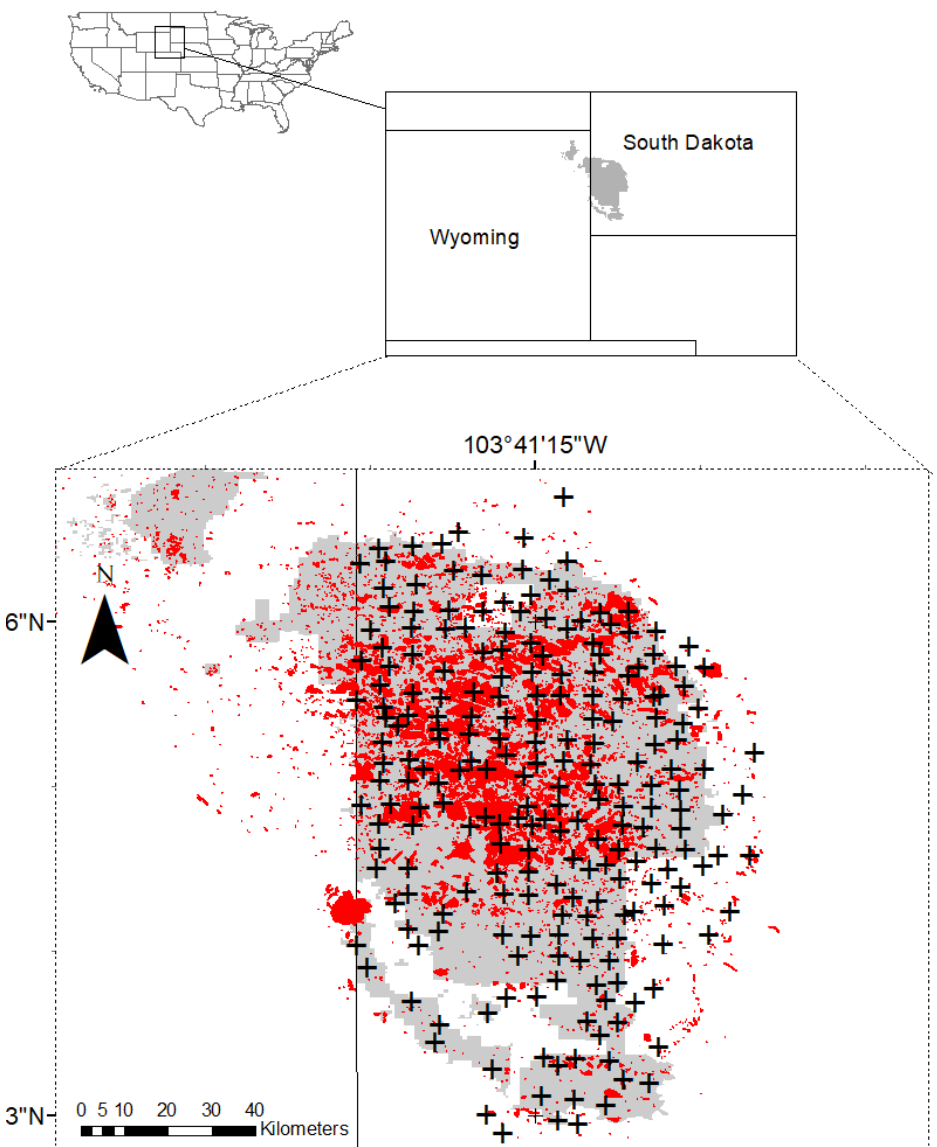
Figure 1. Map showing plot locations (cross hatching) in the Black Hills National Forest (indicated in gray) in western South Dakota. Forest Service land is shown in gray. Red polygons denote aerially mapped observations of tree mortality from mountain pine beetle from 2001 to 2016. A subset of data was taken to include ponderosa pines measured within five South Dakota counties covering the Black Hills region (Fall River, Pennington, Custer, Law- rence, and Meade). Data were further subset to include only trees that were alive at initial measurement and were remeasured at least once. Trees were excluded from the analysis if they were harvested, killed for silvicultural reasons, or had a noninsect mortality agent (fire, weather, animal, etc.). Although most of the damage during our observation period was likely attributable to the mountain pine beetle ( Dendroctonus ponderosae Hopkins), these events are often accompanied by outbreaks of secondary and related bark beetle